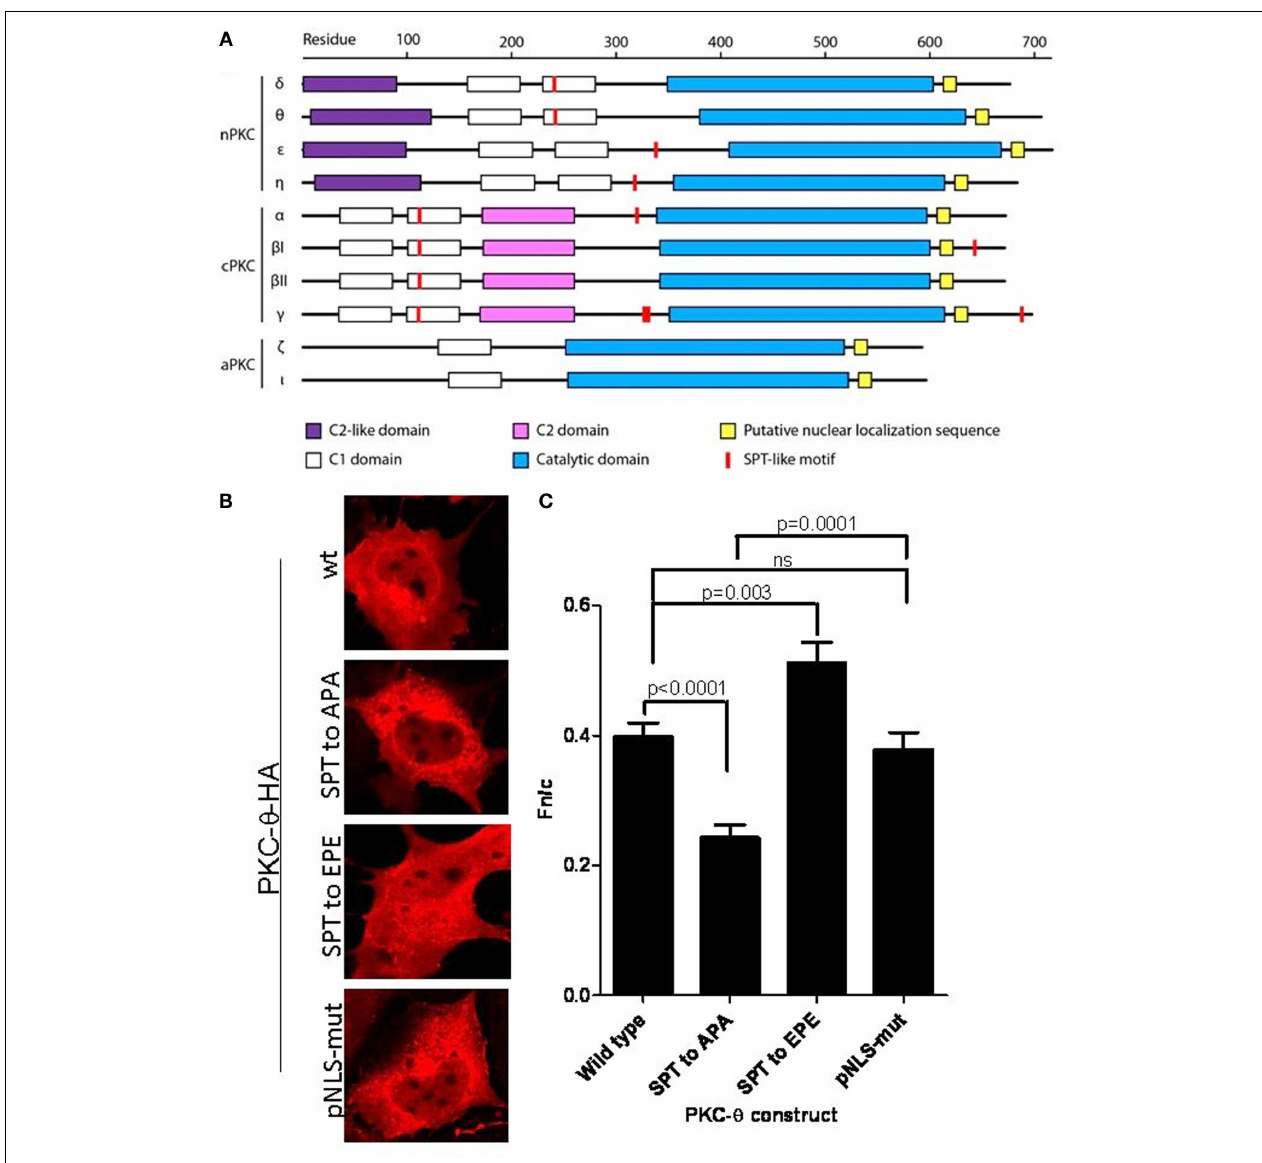
non-phosphorylatable alanine (SPT to APA) or the phosphomimetic glutamine (SPT to EPE), were cloned into the pTracer-CMV vector in frame with a C-terminal HA-tag.The vector also codes for GFP, which is translated independent of the insert and serves as an internal marker for transfected cells. Subconfluent cultures of Cos-7 cells were transfected and subsequently the fixed cells were probed with rabbit antibody to HA-tag, followed by secondary antibody to rabbit immunoglobulins conjugated to Alexa-Fluor 568. Localization of expressed PKC- θ was studied with confocal laser scanning microscopy as detailed in the methods. Representative images for each construct are shown. (C) F n/c values for each construct are shown in (C) , with significant differences between datasets indicated. Data shown are mean ± SEM, n > 15 for each